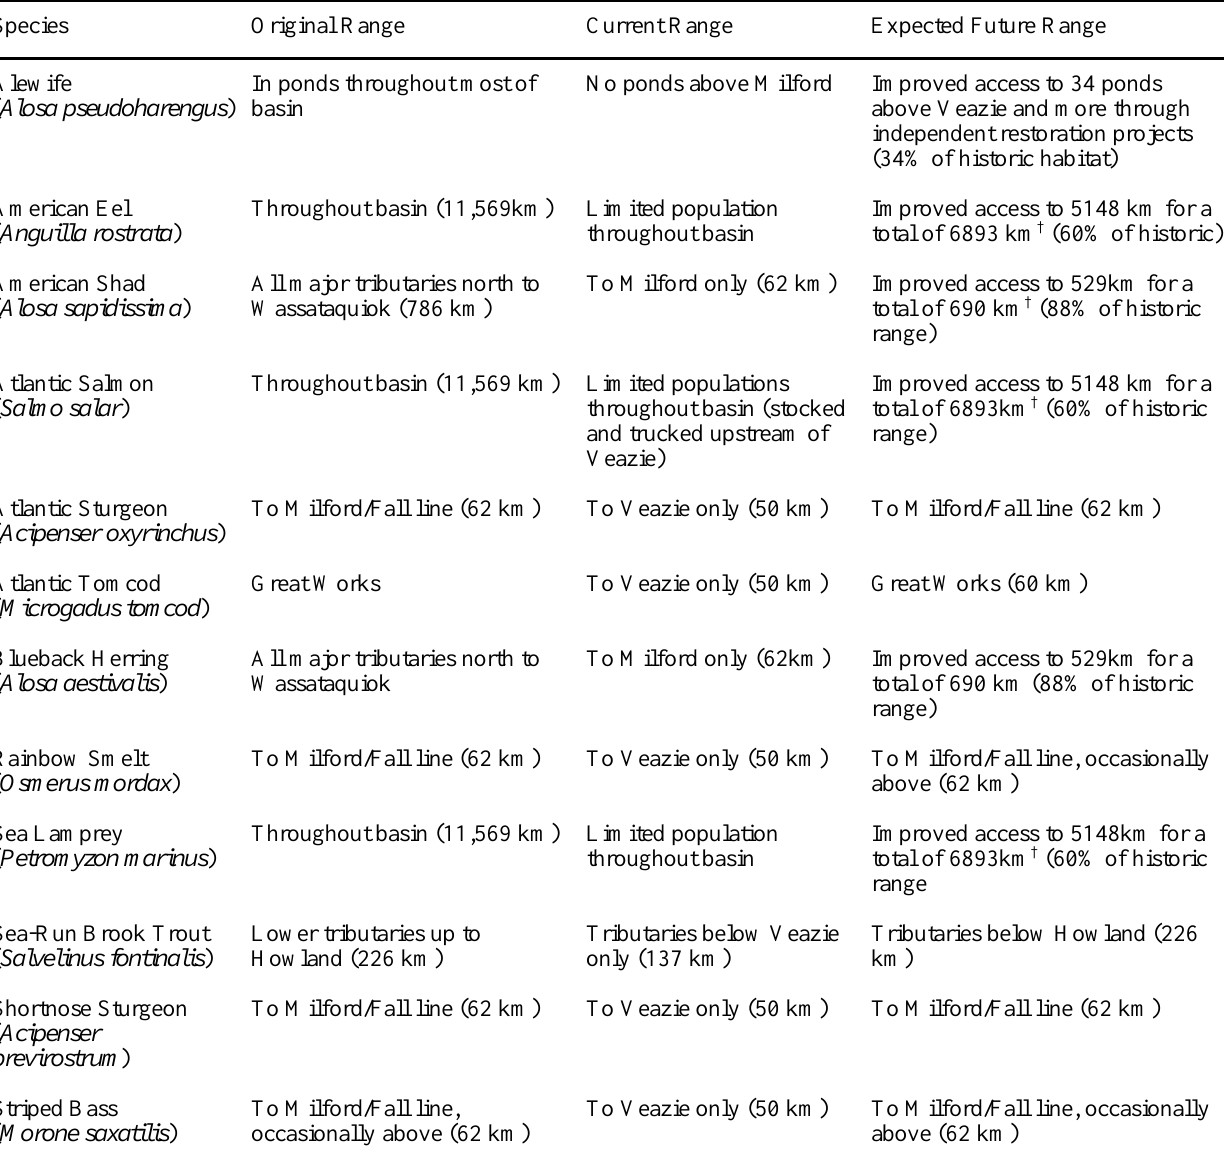
Table 1. Migratory fish in the Penobscot basin, including original range of migration, current range, and projected range after Project